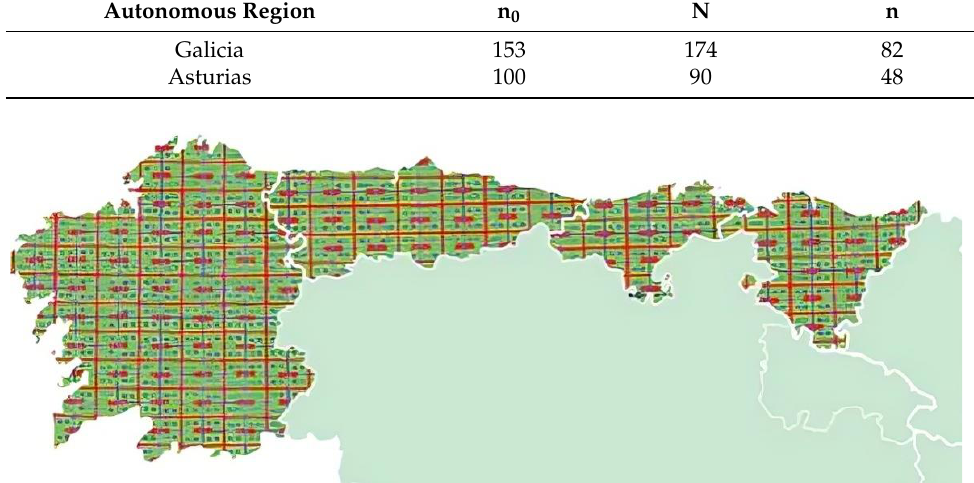
Figure 1. Map of the Cantabrian coast with ASPAPEL’s sampling grid. The sampling points were randomly